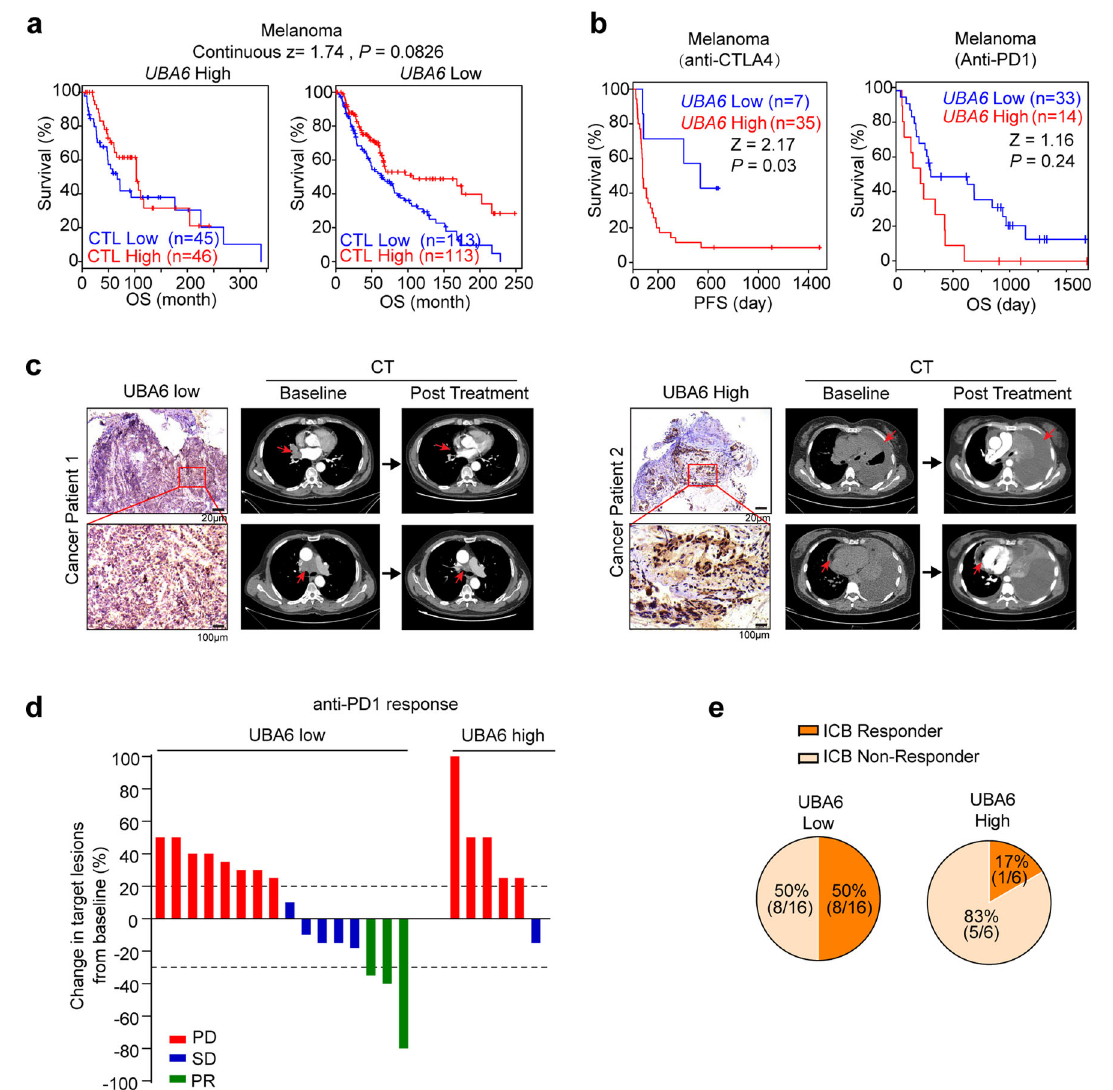
d Waterfallplotdepictingtheresponsestoanti-PD1treatmentbythebestchangein the sum of target lesions, in comparison to baseline, in cancer patients with low UBA6 ( n =16) or high UBA expression( n =6). Everybarrepresents one patient and the colours correspond to response to anti-PD1 treatment ( PR partial response, SD stabledisease, PD progressive disease).Dottedblacklinesindicate the response as describedbyRECIST1.1. e Piechartsofresponsefractionsforeachgroupofpatients with UBA6-low and UBA6-high expression in tumour cells. Data are presented as Mean±s.e.m. Statistical signi fi cance was determined by a log-rank test ( a , b ). Source data are provided as a Source Data fi